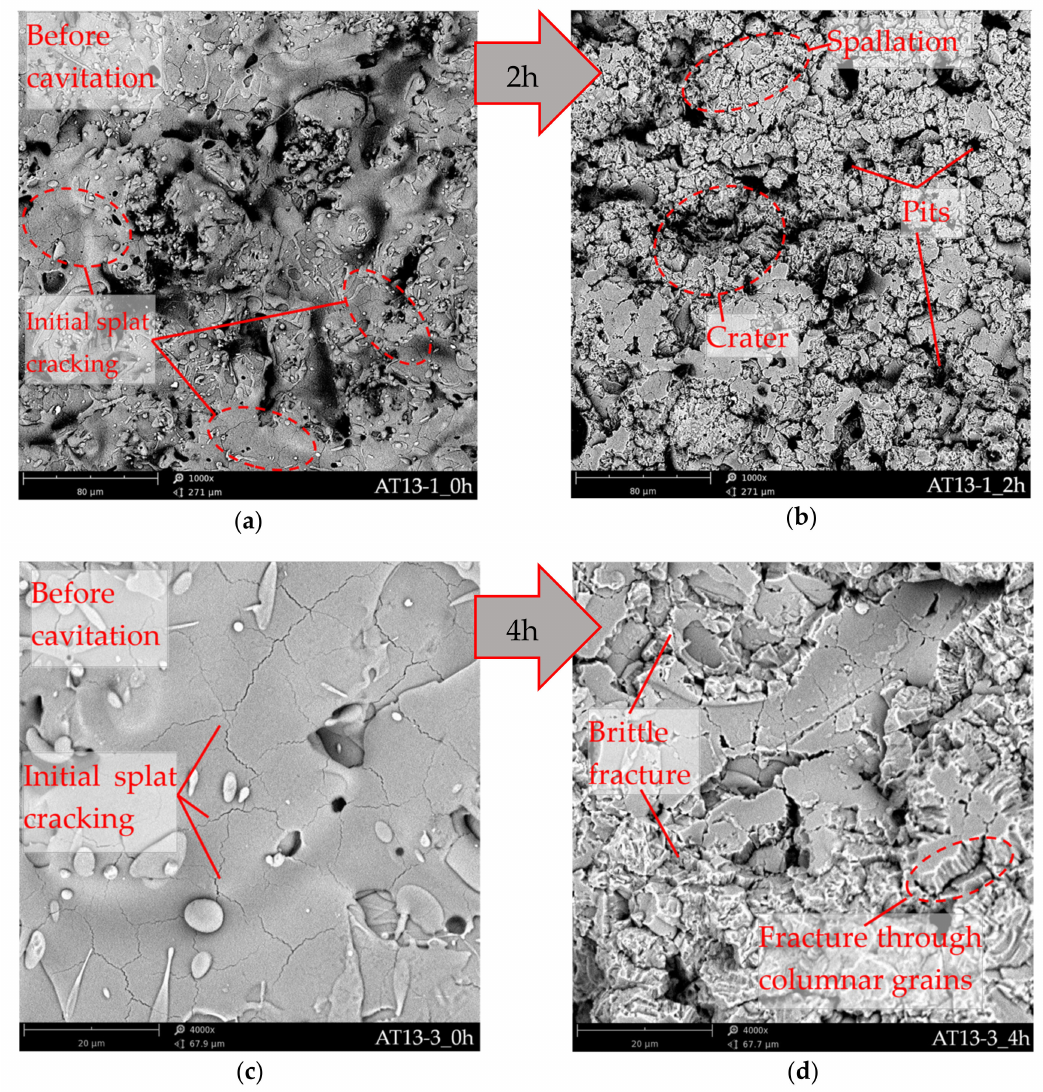
Figure 4. Cavitation damage development observed at di ff erent magnifications and exposure times: ( a , b ) progression of erosion in the AT13-1 coating before and after 2 h of cavitation, × 1000; ( c , d ) progression of erosion in the AT13-3 coating after 4 h of cavitation testing, × 4000,